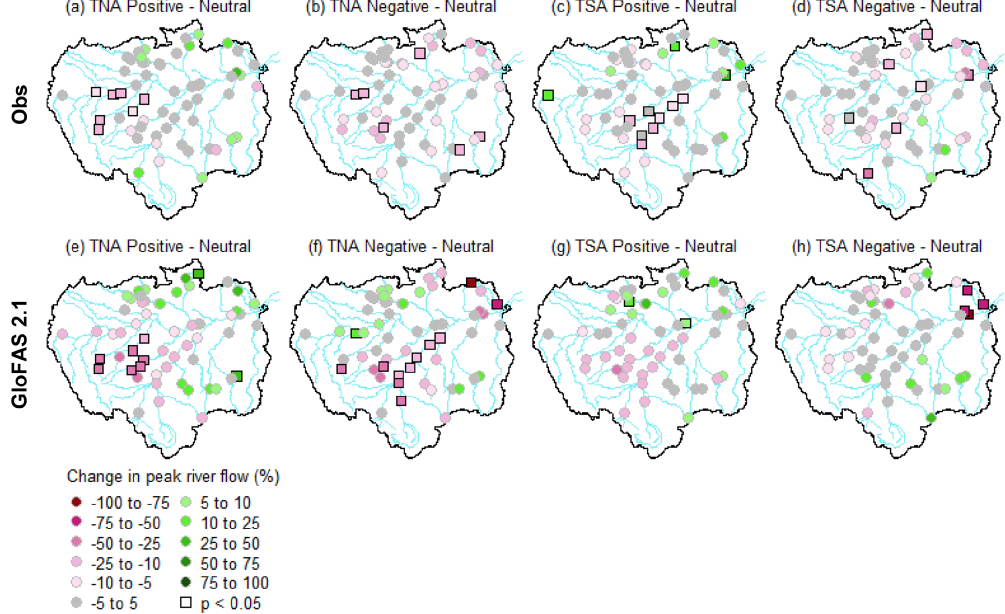
Figure 4. Percentage change of observed and simulated mean annual peak river flows between different phases of tropical Atlantic indices. (a, c, e, g) Positive with respect to neutral years. (b, d, f, h) Negative with respect to neutral years. Panels (a–d) represent changes for observations and panels (e–h) show changes for GloFAS 2.1 streamflow reanalysis data. Pink (green) points represent where the average annual peak flow decreases (increases). Significant results at the 95% confidence level are denoted using a square (i.e. p < 0 .